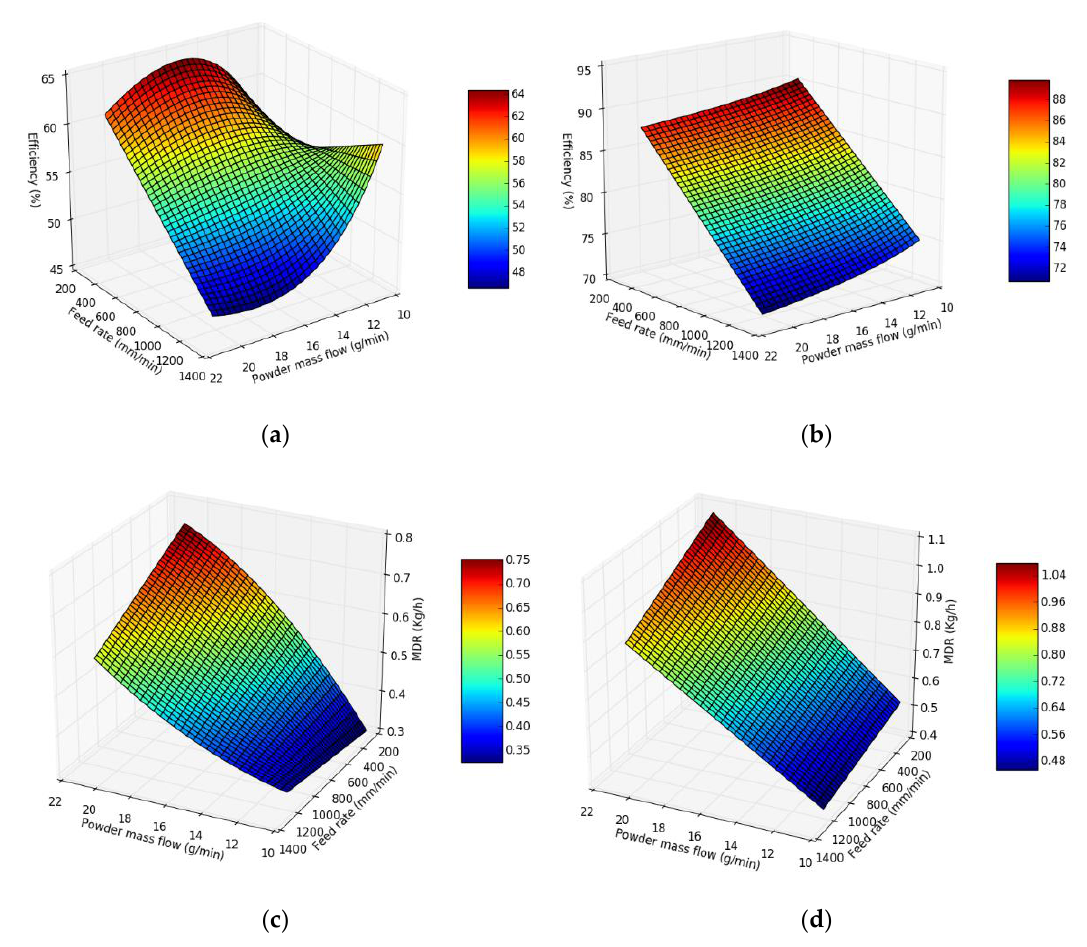
Figure 8. Powder Efficiency and MDR results of the single clad study at 2500 W: ( a , c ) four-stream nozzle; ( b , d ) continuous coaxial nozzle.